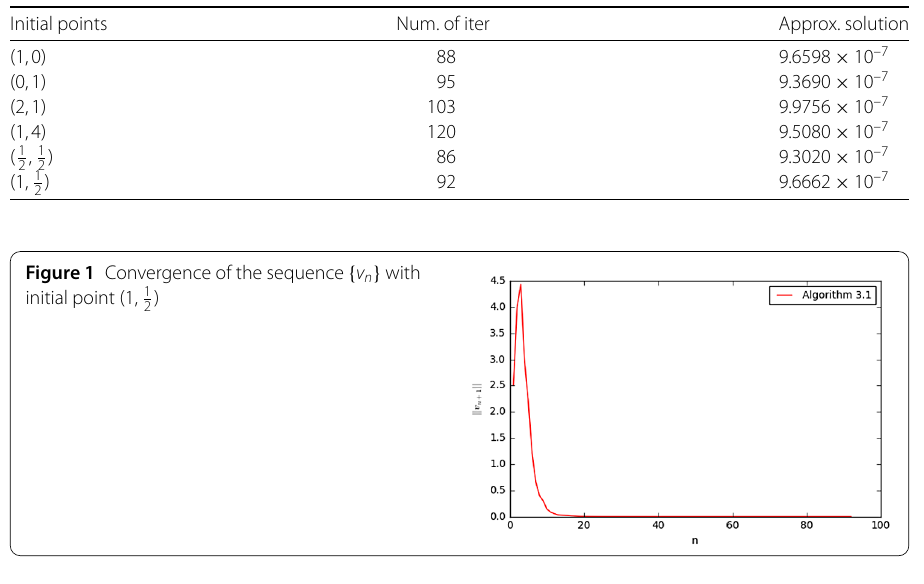
Table 2 Numerical illustration for the solution of Hammerstein integral equation Initial points Num. of